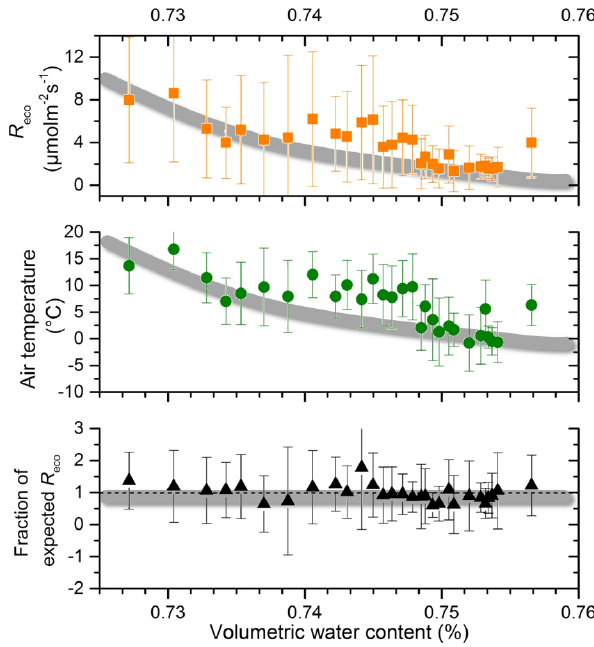
Figure 5. Relationship between VWC and R eco (non-gap-filled), air temperature and the fraction of expected R eco (measured R eco /modeled R eco by temperature relation). Each point is the av- erage of 100 non-gap-filled half-hourly measurements. The verti- cal bars denote the standard deviations. The grey line represents an exponential dependence. Plots show binned data from 2011 at